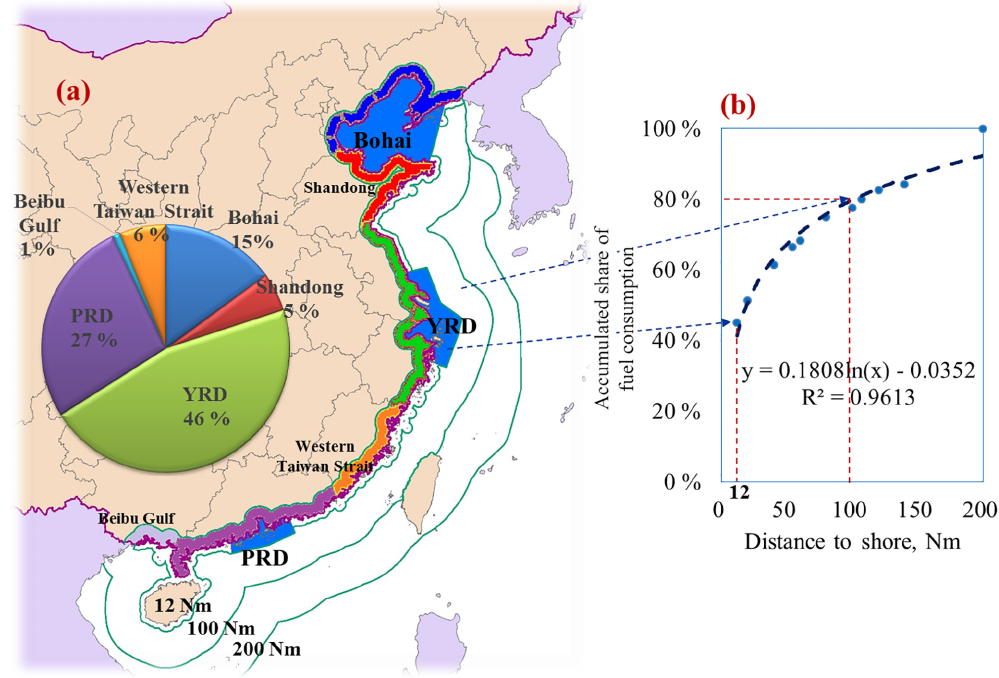
Figure 3. (a) Fuel consumption contributions of different port groups within 200Nm and (b) the cumulative distribution of fuel consumption within